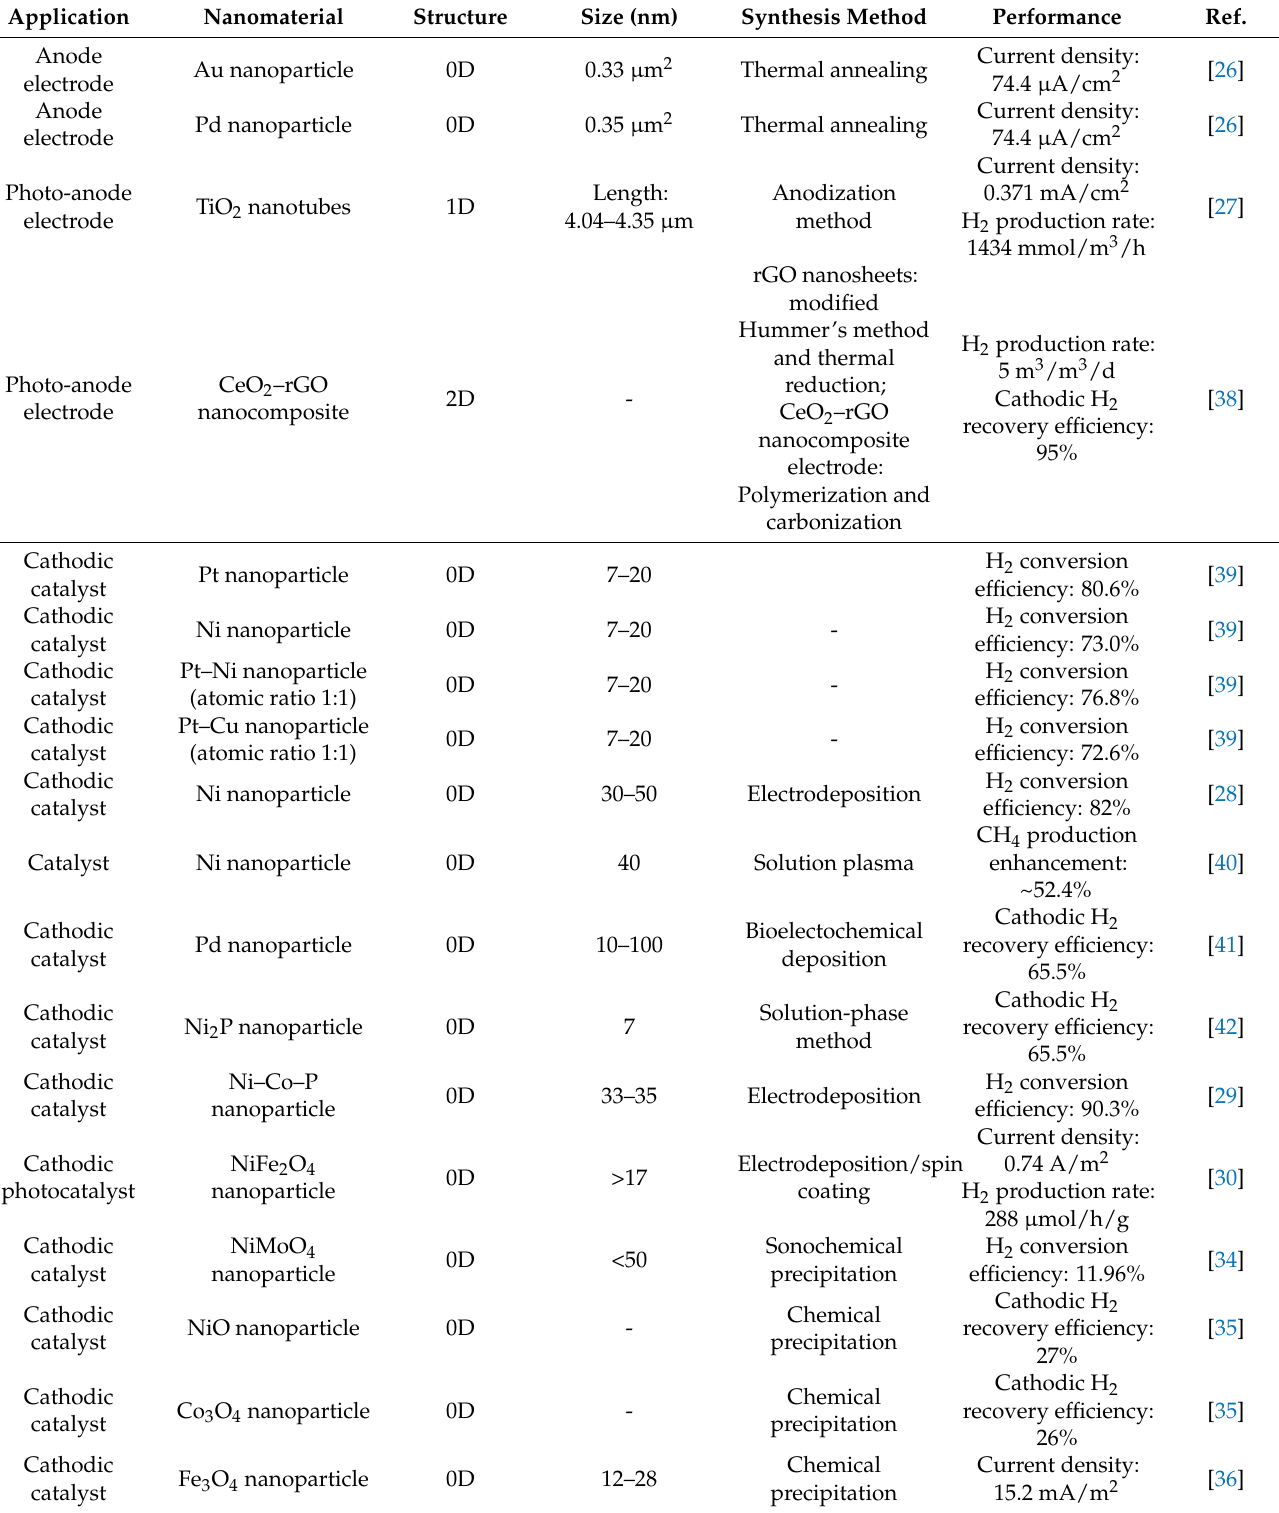
Table 1. Summary of nanomaterials employed in microbial electrolysis